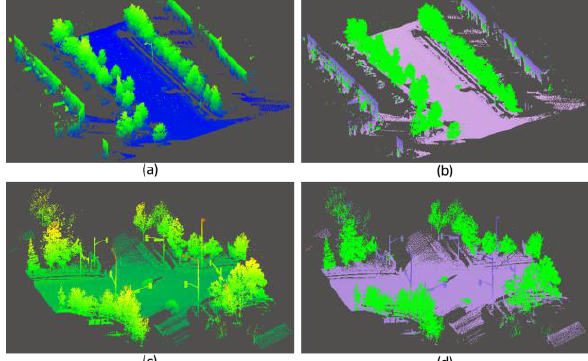
Figure 6. Experimental results of the mobile LiDAR dataset. (a) The source point cloud, and (b) the vegetation removal result of an area along the road. (c) The source point cloud, and (d) the vegetation removal result of a